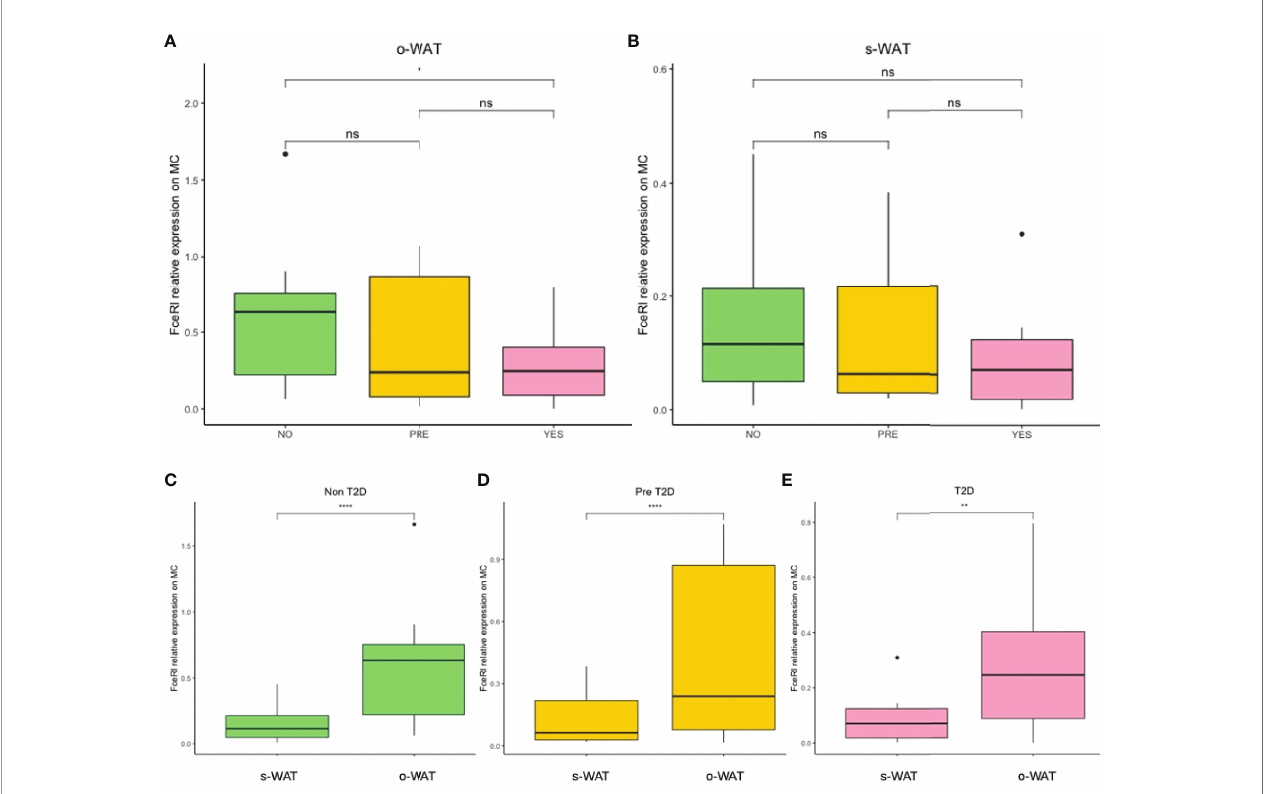
FIGURE 4 | Relative surface expression of FceRI on mast cells. (A) Comparison in o-WAT between the three groups. (B) Comparison in s-WAT between the three groups. (C) Comparison between o-WAT and s-WAT in the non-T2D group. (D) Comparison between o-WAT and s-WAT in the pre-T2D group. (E) Comparison between o-WAT and s-WAT in the T2D group. MC (mast cells), s-WAT (subcutaneous white adipose tissue), o-WAT (omental white adipose tissue), NO (non-type 2 diabetes group), PRE (pre type 2 diabetes group), YES (type 2 diabetes group), T2D (type 2 diabetes), n=60. “ ns ” means not signi fi cant. * (0.05>p value>0.01), ** (0.01>p value>0.001), **** (0.0001>p